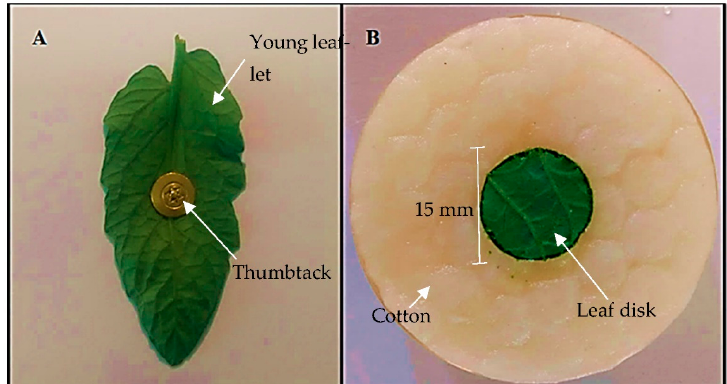
Figure 1. Experimental unit for no ‐ choice, ( A ) traveled distance, and ( B ) oviposition bioassays.